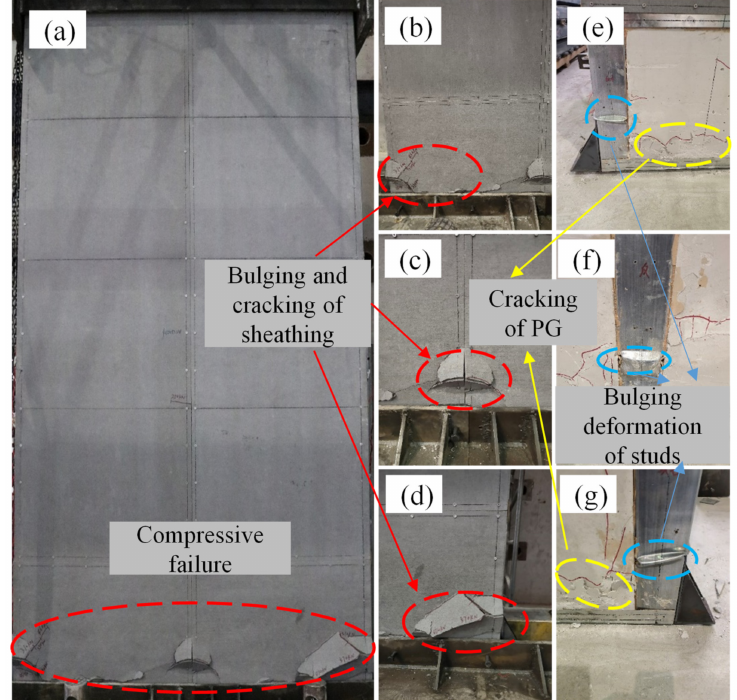
Figure 7. Failure of specimen W3.